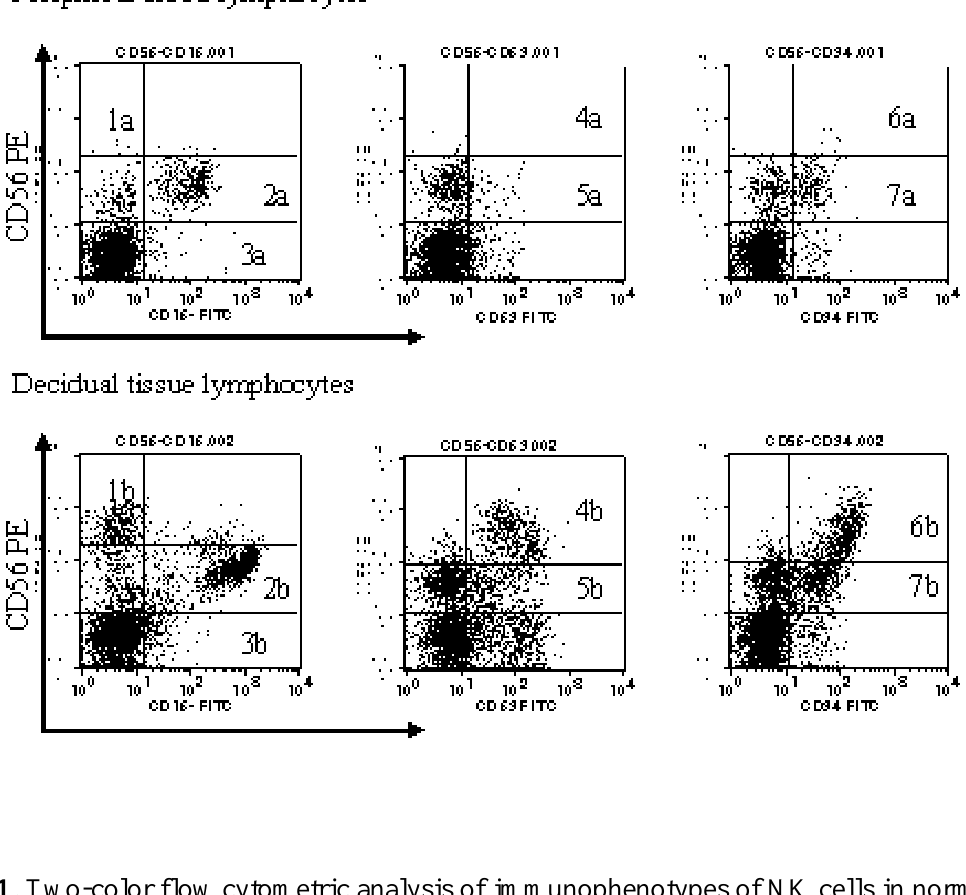
Figure 1 . Two-color flow cytometric analysis of immunophenotypes of NK cells in normal term pregnancy. a, peripheral blood. b, deciduas. 1) CD56 bright CD16 - ; 2) CD56 dim CD16 + ; 4) CD5 6bright CD69 + ; 5) CD56 dim CD69 + ; 6) CD56 bright CD94 + ; 7) CD56 dim CD94 + . Percentages of these cell populations within the lymphocytes were: 1a, 0.2 %. 1b, 7.15 %. 2a, 12.13 %. 2b, 27.4 %. 4a, 0.01 %. 4b, 7.17 %. 5a, 3.09 %. 5b, 12.39 %. 6a, 0.24 %. 6b, 8.59 %. 7a, 7.79 %. 7b, 17.54 %